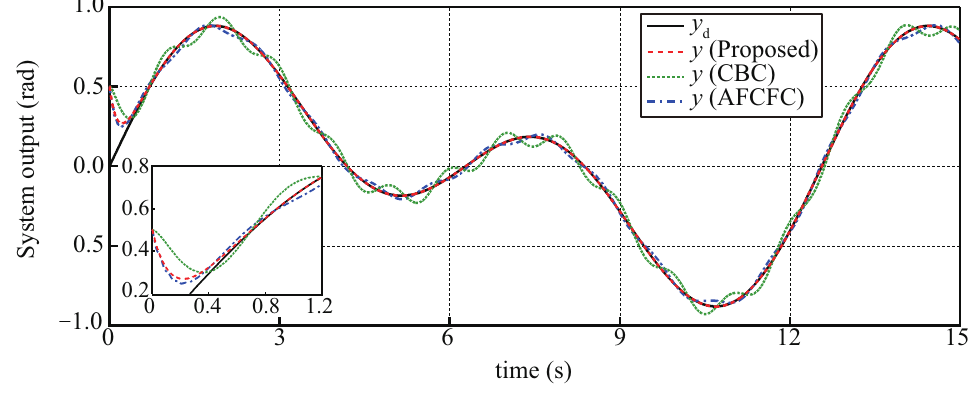
Figure 10. Tracking performance of the system output y under the three controllers.